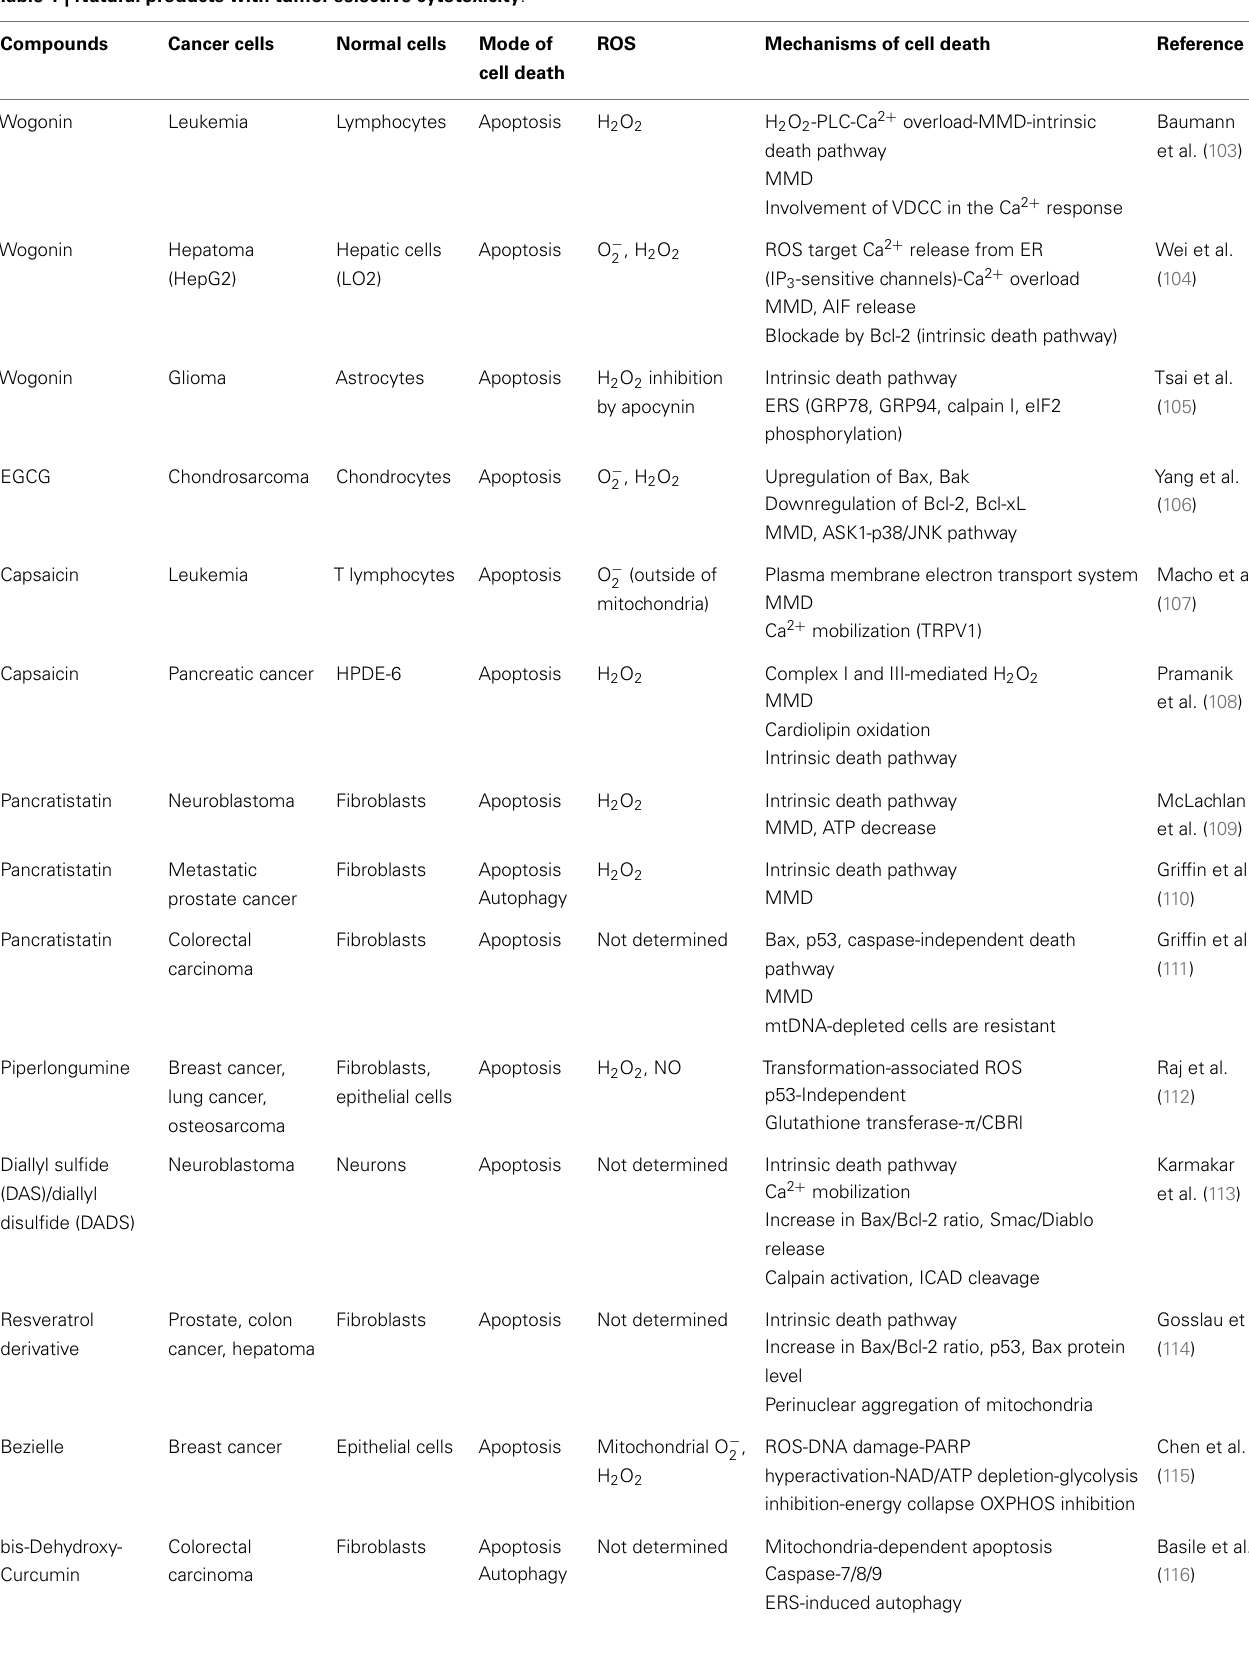
Table 1 | Natural products with tumor-selective cytotoxicity